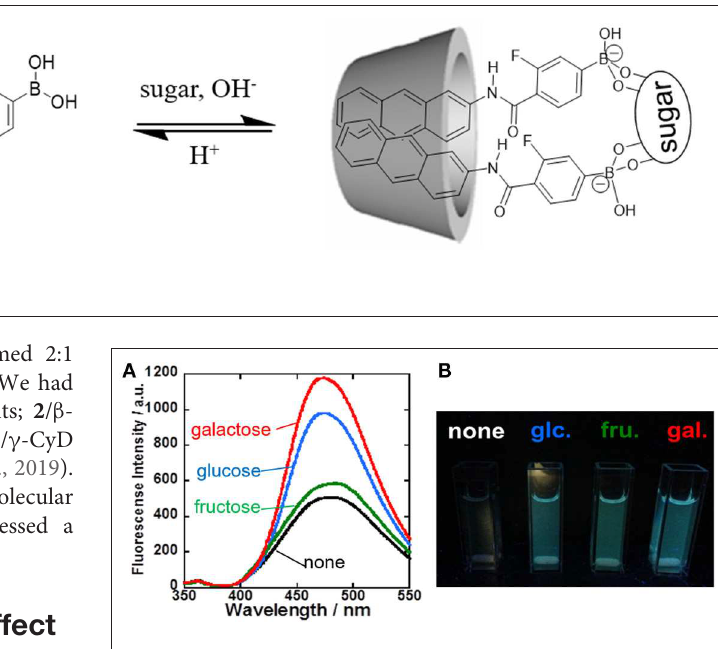
FIGURE 4 | (A) Fluorescence spectra of 1 / γ -CyD complex with various sugars (none: black; green: fructose; blue: glucose; red: galactose) in 2% DMSO − 98% water (v/v) at basic condition around pH 10. [ 1 ] = 10 µ M, [ γ -CyD] = 5mM, [sugar] = 0 or 30mM, [phosphate buffer] = 10mM, [NaCl] =